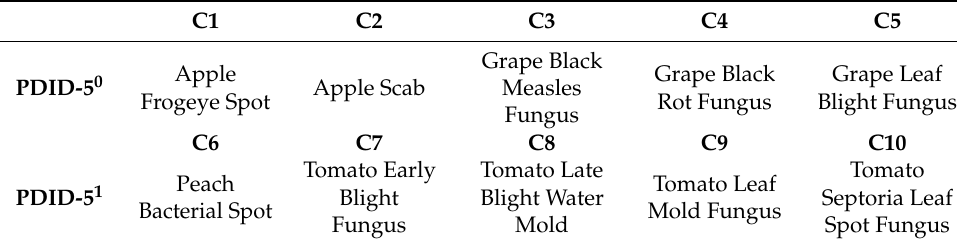
Table 1. Category names in dataset PDID-5 i .